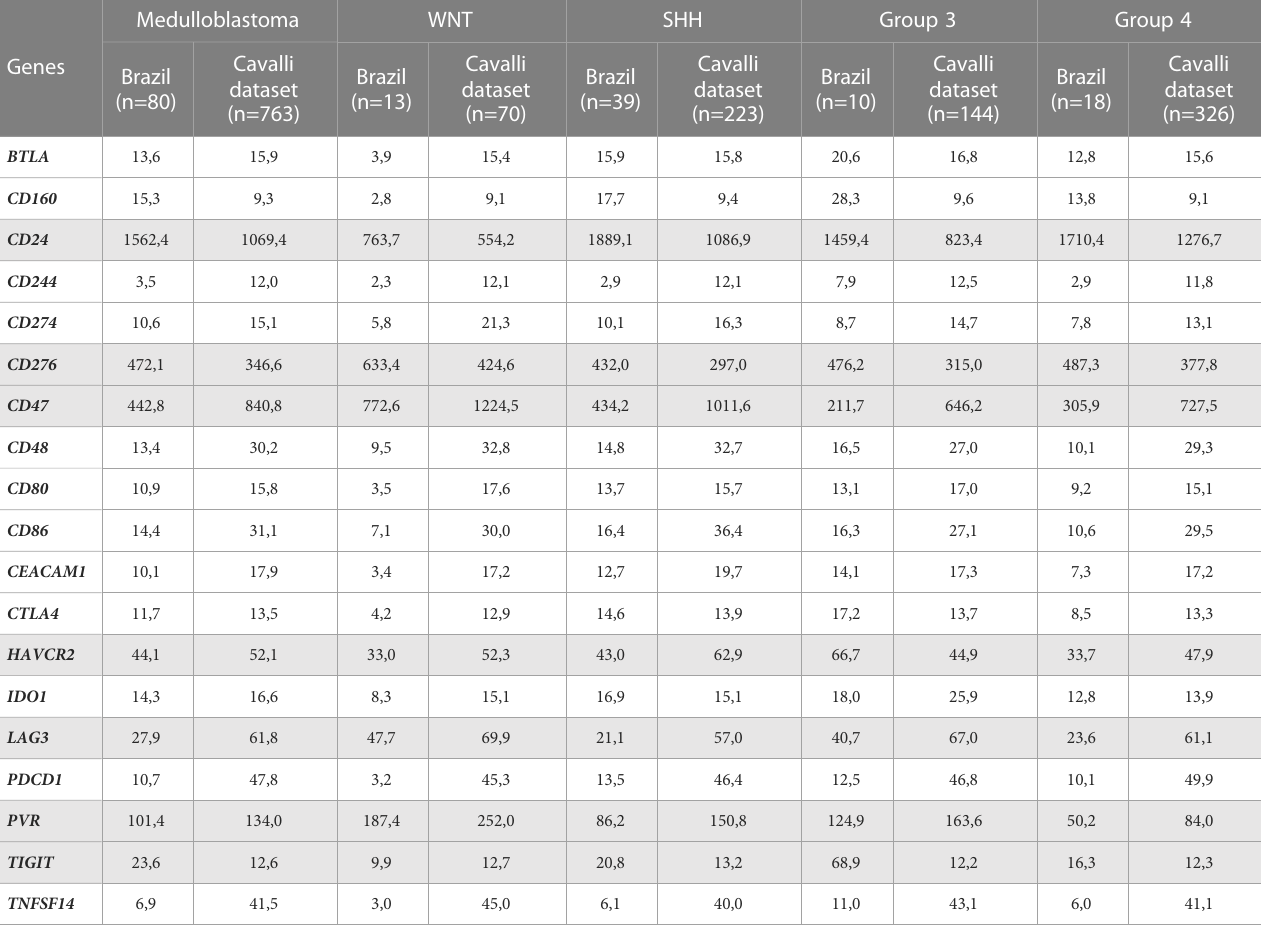
TABLE 2 Mean mRNA normalized counts of the immune checkpoints evaluated in the Brazilian and Cavalli cohorts.